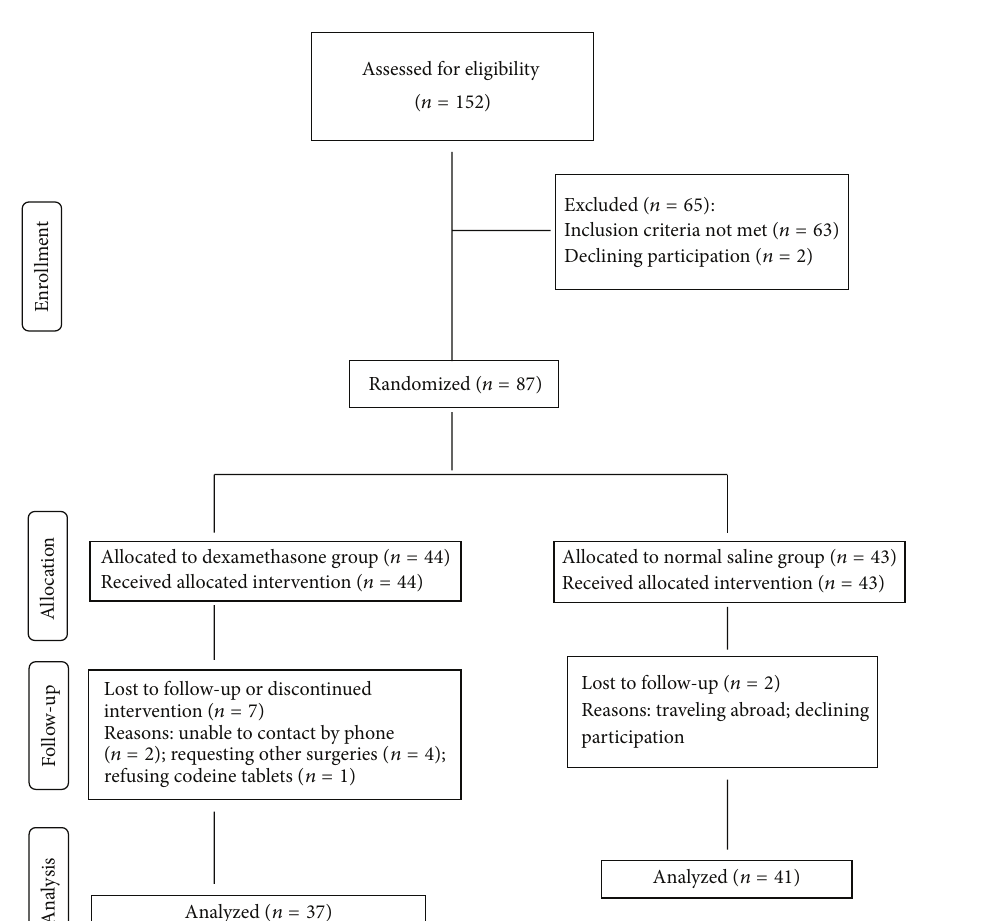
Figure 1: Study flow